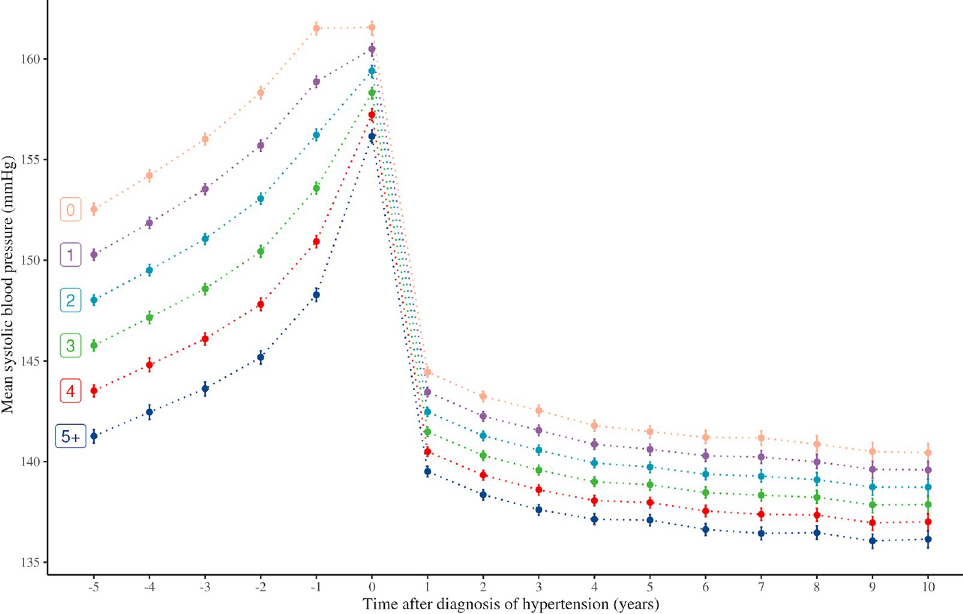
Fig 2. Mean SBP over time by number of comorbidities. SBP was calculated from linear regression models for each landmark cohort. Each line represents number of comorbidities in addition to hypertension: 0,1,2,3,4,5+. Bars for each dot represent 95% CIs. Negative time indicates time (year) before diagnosis of hypertension. Models were adjusted for age, sex, deprivation level, ethnicity, BMI, smoking status, number of classes of prescribed antihypertensive medications, and year of diagnosis of hypertension. BMI, body mass index; CI, confidence interval; SBP, systolic blood pressure.